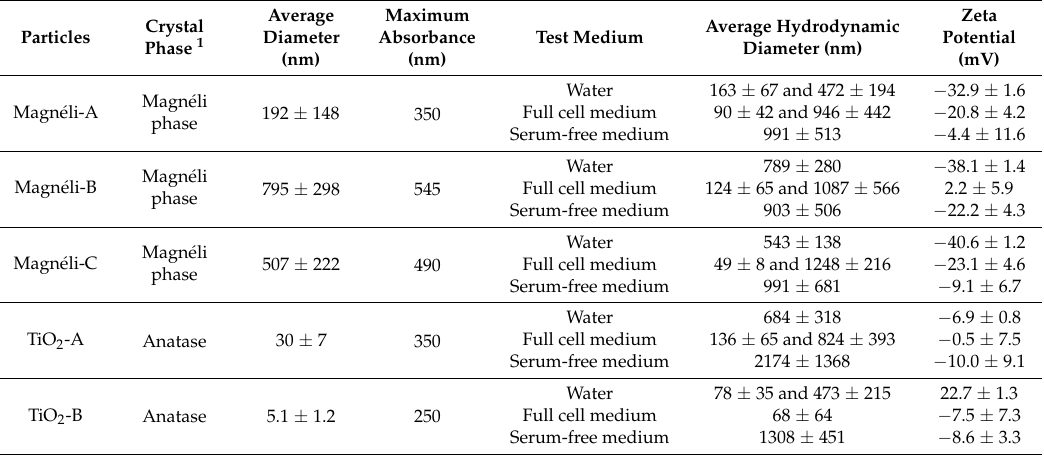
Figure 1. Transmission electron microscopy images of ( a ) Magn é li-A nanoparticles, ( b ) Magn é li-B nanoparticles, ( c ) Magn é li-C nanoparticles, ( d ) TiO 2 -A nanoparticles, and ( e ) TiO 2 -B nanoparticles. Table 1. Physicochemical properties of the studied particles in different test media.